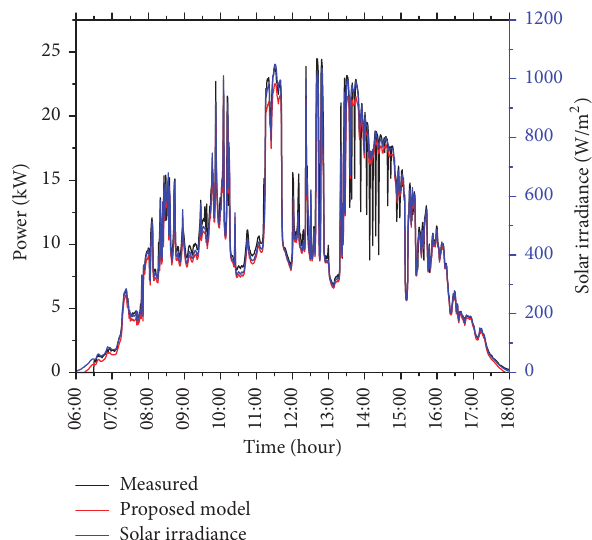
Figure 8: Prediction and measured PV power output on 31st Mar 2015 (cloudy